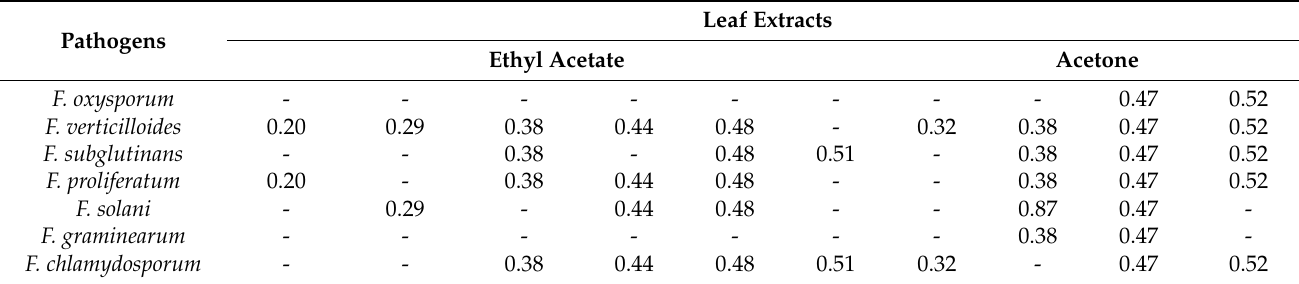
Table 1. R f values of antifungal bands in Combretum erythrophyllum leaf extracts using the TLC bioautography assay. Pathogens